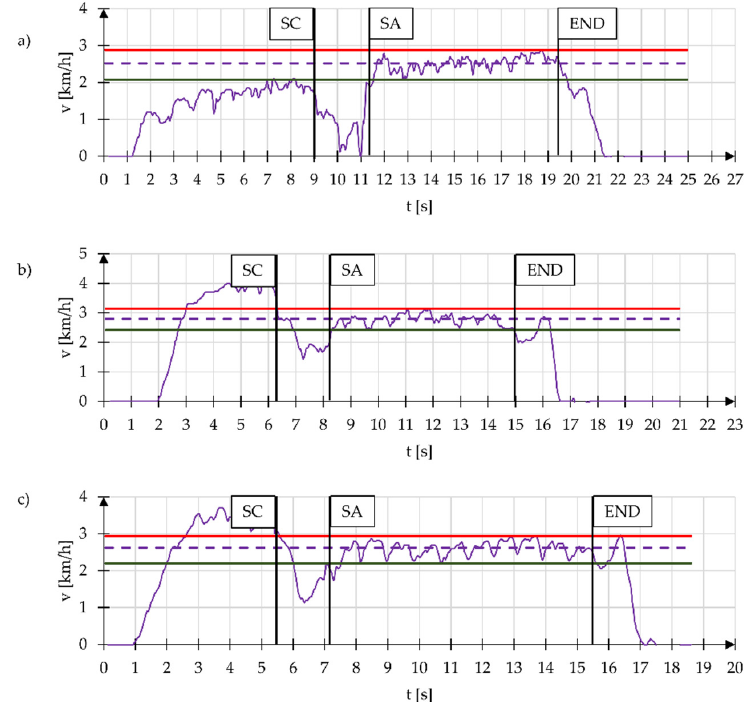
Figure 6. Speed waveforms of a wheelchair for Hill Climb Assistance Mode (t3) with amplification coefficient w = 50% for subject 1 ( a ), subject 2 ( b ) and subject 3 ( c ), where SC – the starting points for the slope climb, SA – the starting points for the assistance mode, END – the end points for the slope